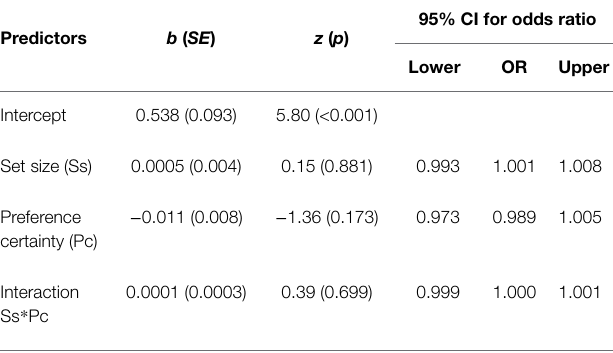
TABLE 2 | Model coefficients from logistic regression predicting donation